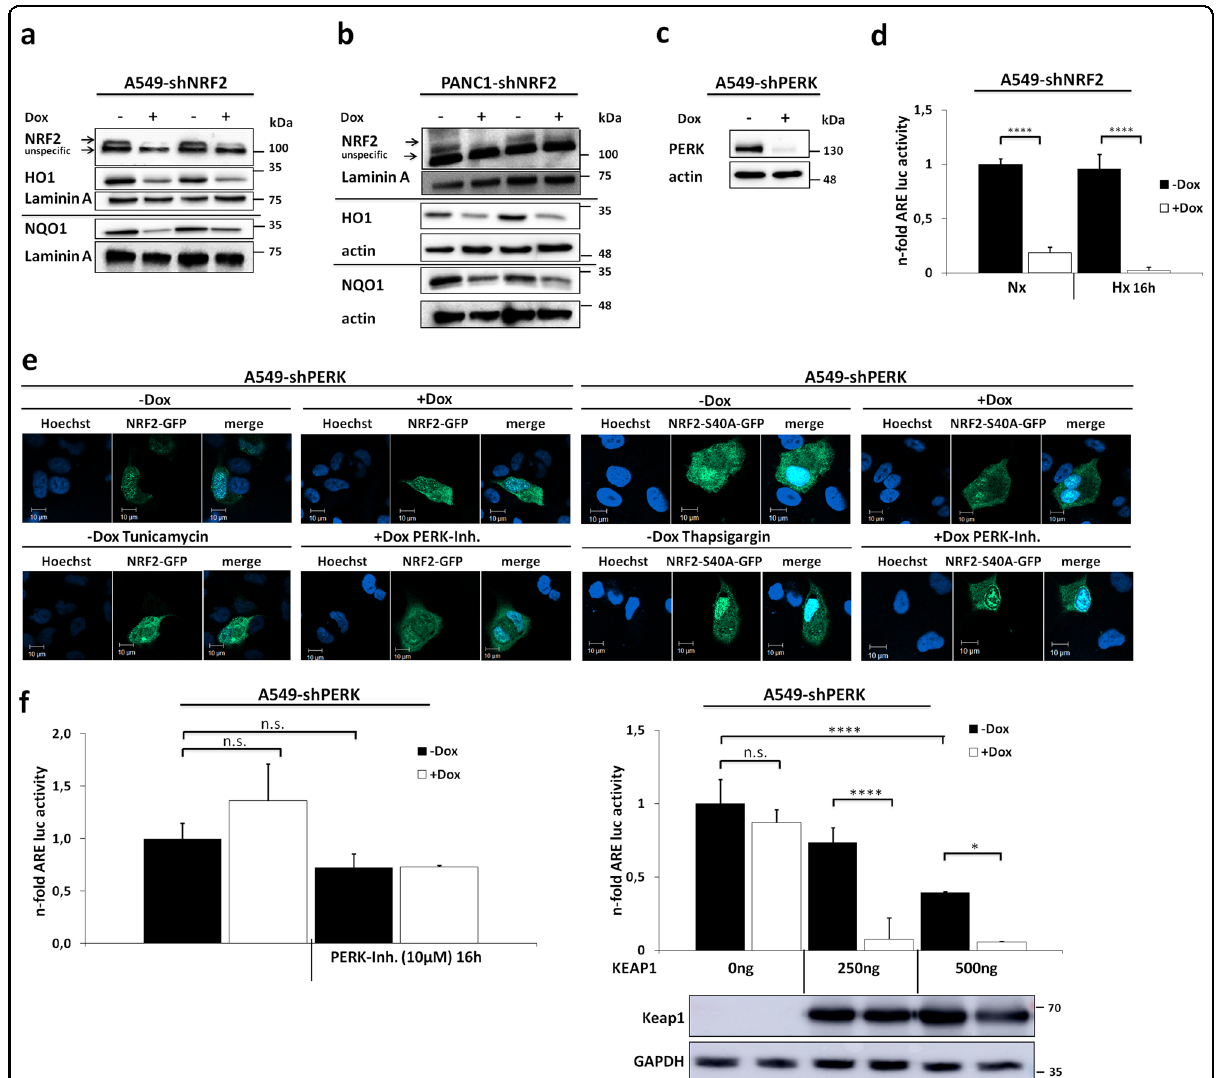
Fig. 1 Relevance of PERK for nuclear translocation, transcriptional activation, and stability of NRF2 in A549-shPERK cells. a – c Western blot analysis of total lysates of lentiviral-transduced A549-shNRF2, PANK1-shNRF2, and A549-shPERK cells showing protein expression for NRF2, its downstream targets HO1 and NQO1 ( a , b ) and PERK ( c ) 48 h after KD induction. Laminin A and actin were detected as loading controls. d Luciferase activity assay was performed in A549-shNRF2 cells transfected with pGL3-8xARE, expressing fi re fl y luciferase downstream of an antioxidant- responsive element (ARE), and pGL4.74 (renilla luciferase) for normalization. Seventy-two hours after KD induction and 16 h in normoxia or hypoxia, whole-cell lysates were used for measurement. e Confocal microscopy of A549-shPERK cells transfected with pEGFP-NRF2 (left panel) or pEGFP-NRF2- S40A (right panel). UPR was stimulated either by 1 µM Thapsigargin or 1 µM Tunicamycin. In addition to a PERK KD, 10 µM PERK-Inhibitor GSK2656157 (PERK-Inh.) was used to eliminate any PERK signaling. Hoechst 33342 was used to stain cell nuclei. f To test transcriptional activity of NRF2 without PERK, cells were transfected with pGL3-8xARE and pGL4.74. Seventy-two hours after PERK KD and 24 h after chemical PERK inhibition, luciferase assays were performed. In addition, KEAP1 dysfunction in A549 cells was counterbalanced by co-transfection with different amounts of plasmid Flag-Keap1 expressing functional KEAP1 protein (right panel). Western blot analysis of total lysates with a Flag antibody showing protein expression for Flag- Keap1. GAPDH was detected as loading